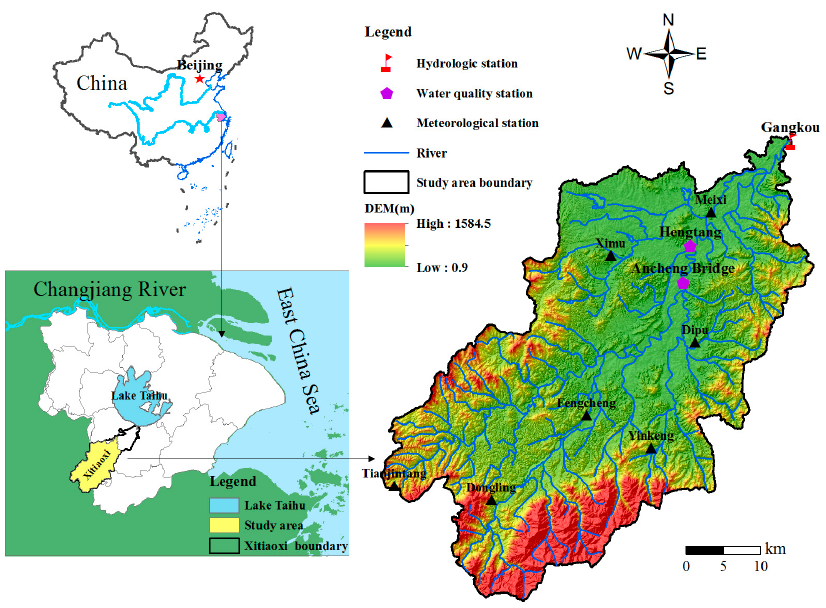
Figure 1. Location of the Xitiaoxi watershed and distribution of hydrologic, water quality, meteorological stations.